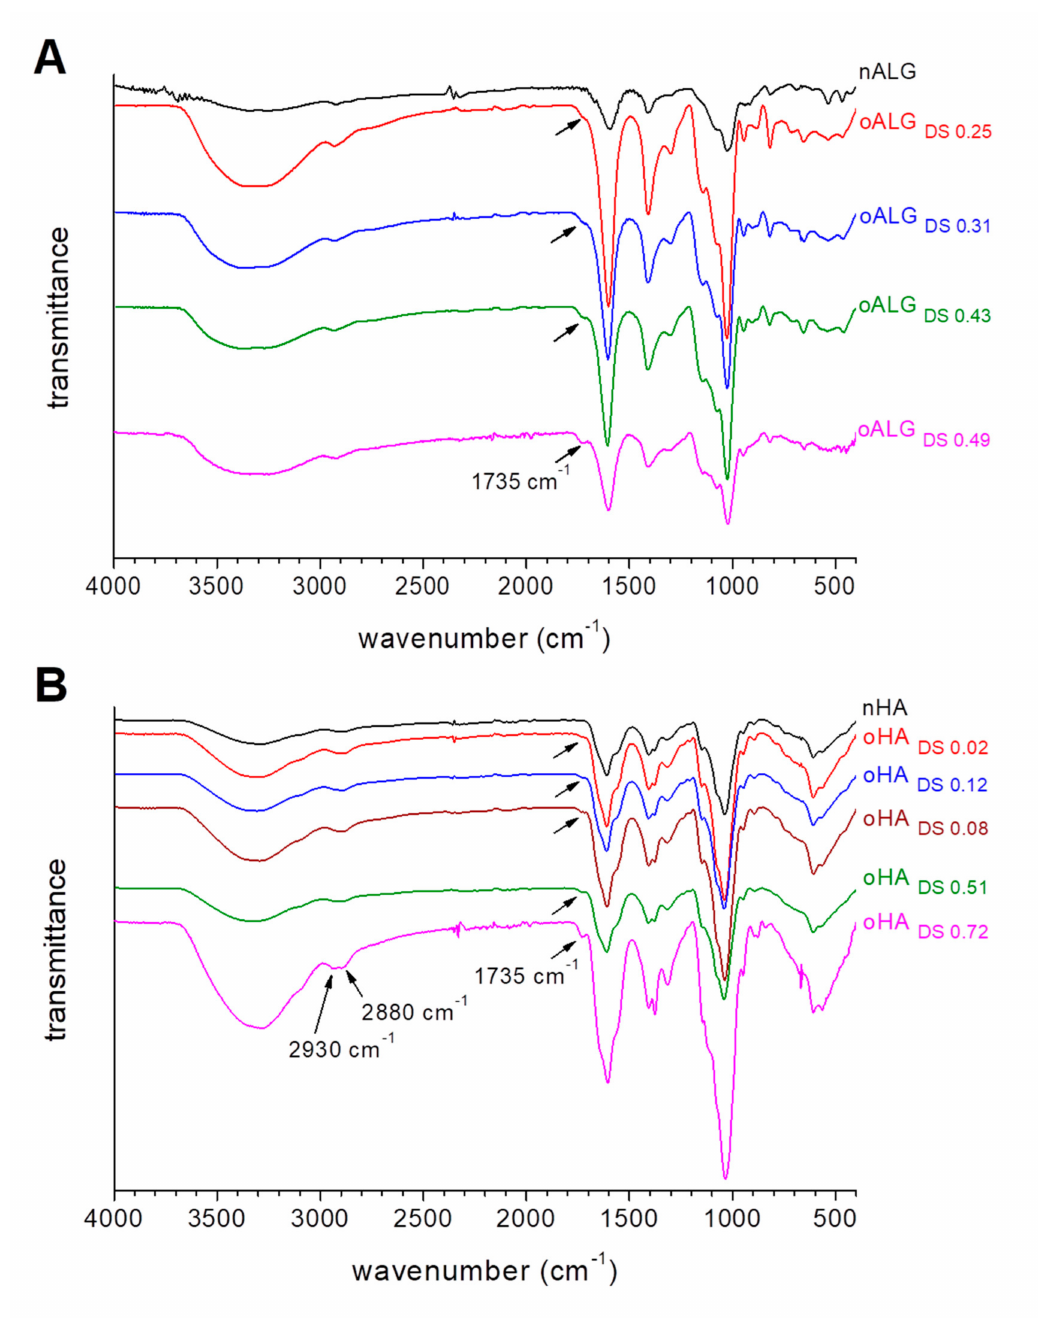
Figure 2. ATR-FTIR spectra of native and oxidized derivatives of ( A ) alginate and ( B ) hyaluronic acid. The curves are vertically shifted for a better